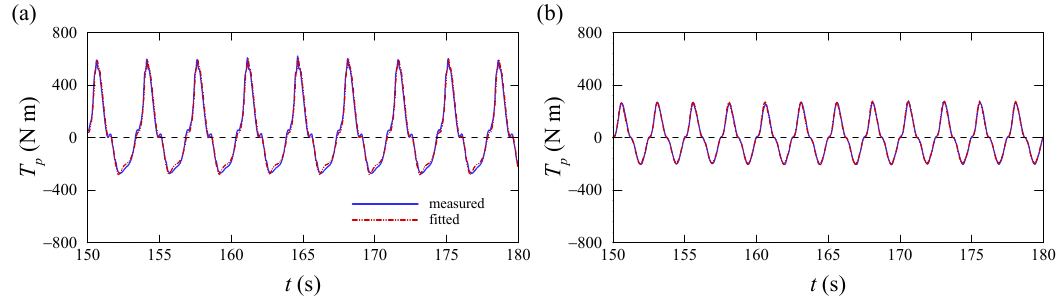
Figure 7. Comparison between measured and fitted torque due to the pressure force of the hydraulic cylinder for ( a ) T = 3.5 s and H = 0.25 m, ( b ) T = 2.5 s and H = 0.2